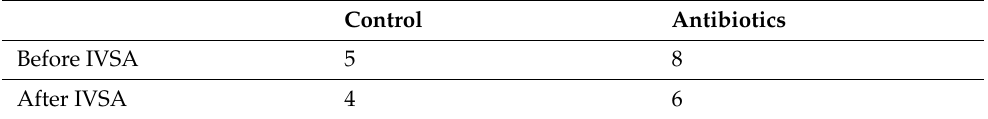
Table 2. Animal numbers per treatment group for fecal microbiome analysis before and after fentanyl intravenous self-administration (IVSA). Only males were used for microbiome analysis due to limited samples.